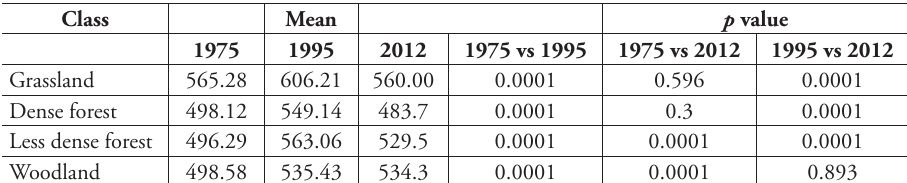
Table 4. Games-Howell tests for the mean parameter area ratio (PARA) in 1975, 1995, 2012. Class